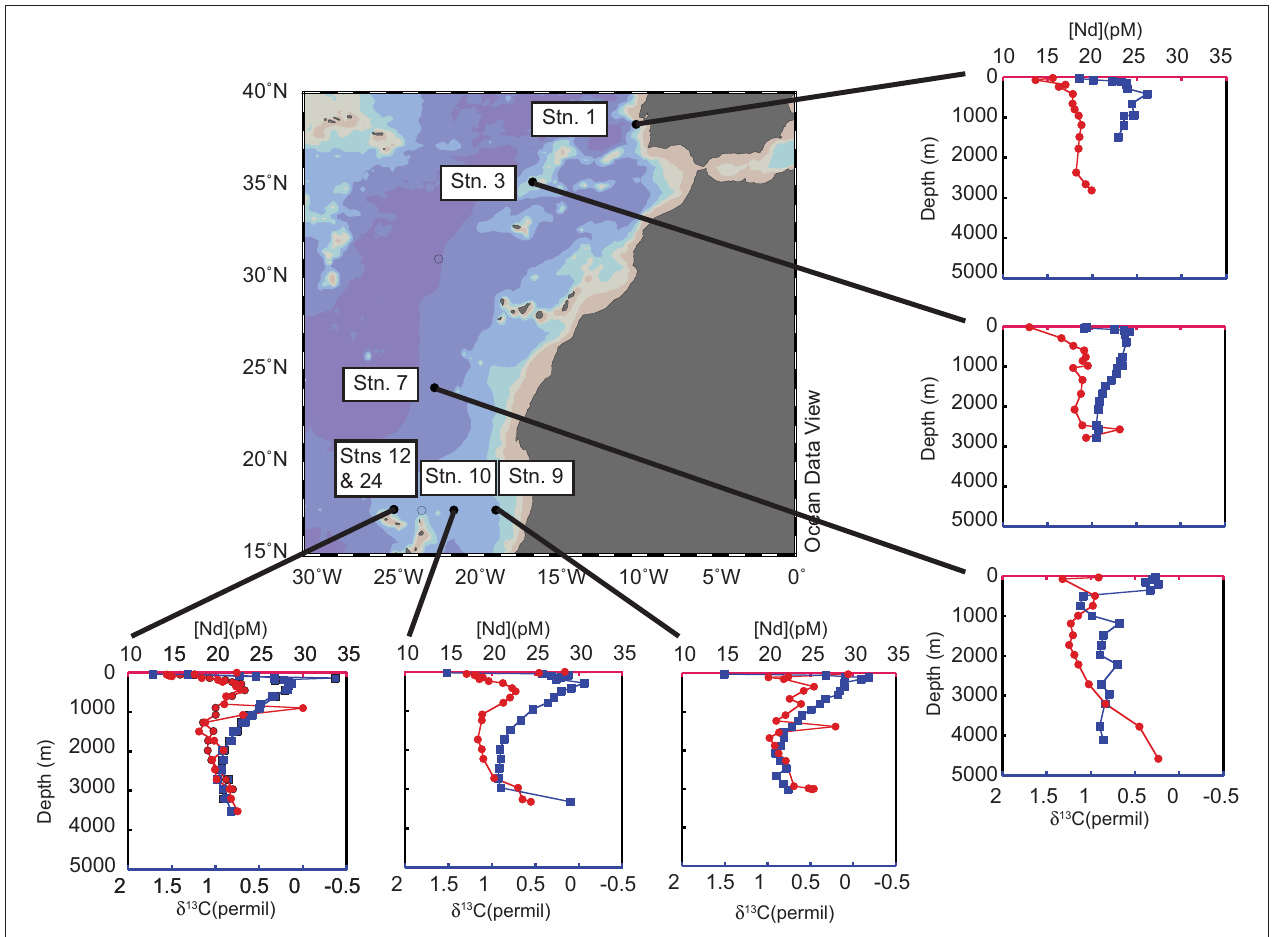
FIGURE 1 | GEOTRACES [Nd] and δ 13 C data from sites in the eastern North Atlantic. Only data where these parameters were available to the sea floor are shown. Data from Mawji et al. (2015) and Stichel et al.